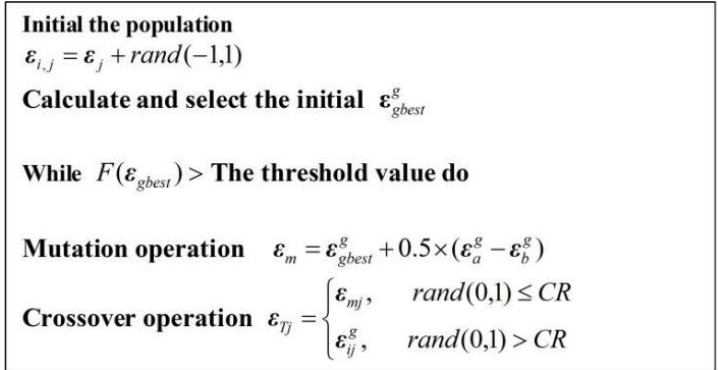
Figure 5. Differential evolution for pre-training the proposed neural network.